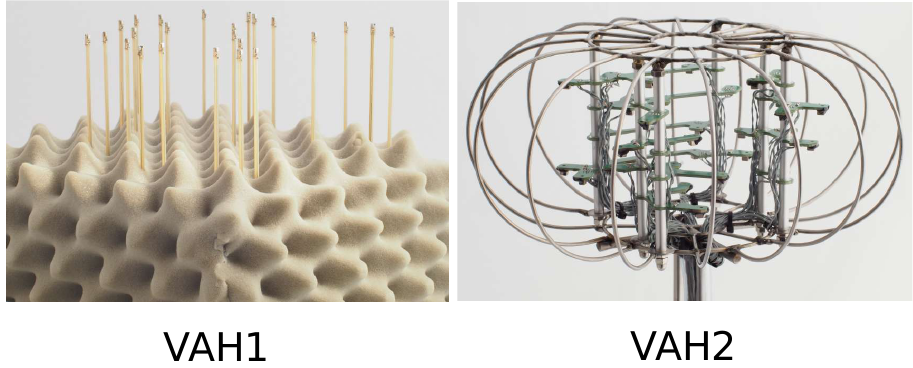
Figure 1. VAHs used in this study. VAH1: a planar microphone array with 24 microphones. VAH2: a 3D microphone array with 31 microphones.